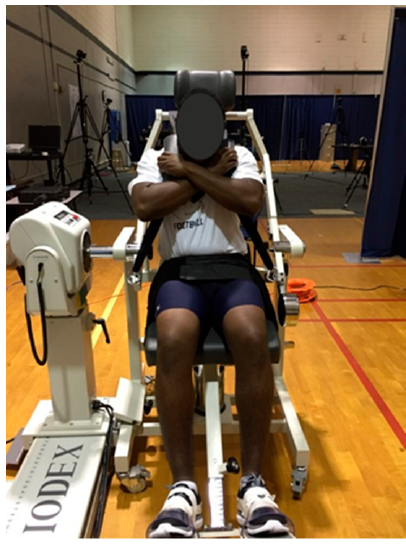
Figure 2. Core strength test setup on a dynamometer.